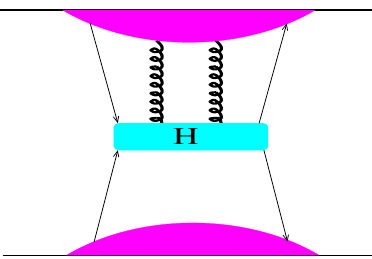
Figure 7. An example diagram for higher twist corrections discussed in the text, for the case of quark-quark hard scattering.